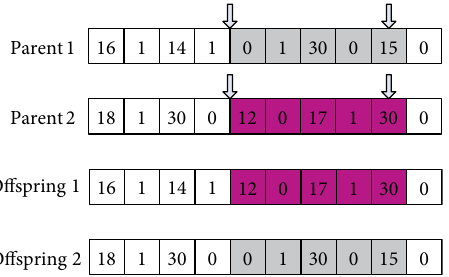
Figure 6: Partly matched